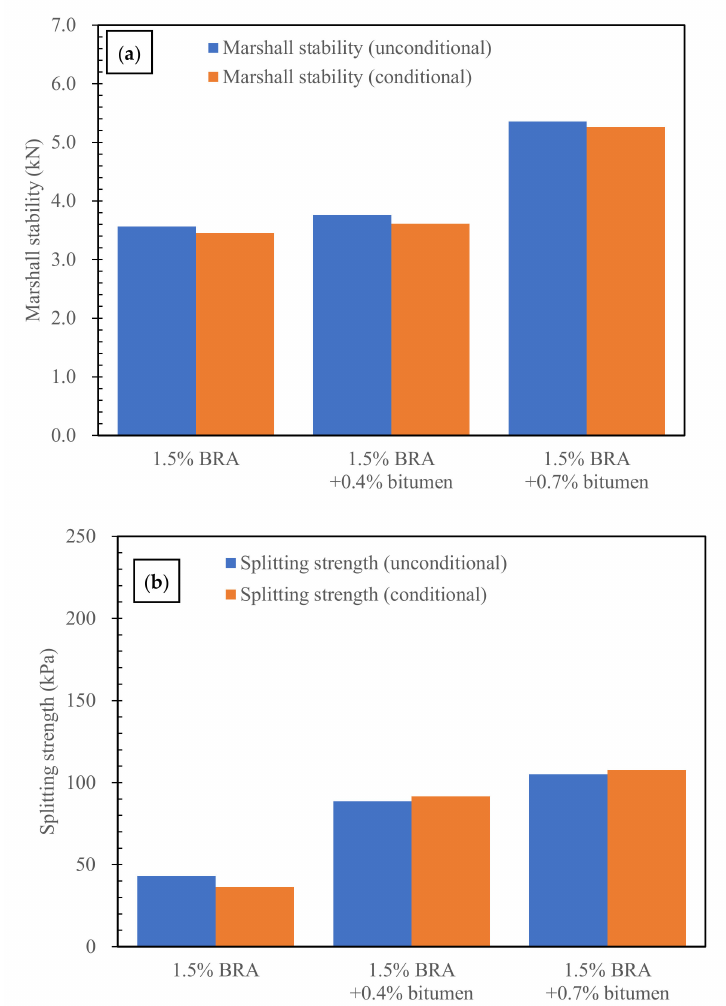
Figure 5. Effects of new bitumen on the mechanical properties of BRA-rejuvenated RAP: ( a ) Marshall stability; ( b ) splitting